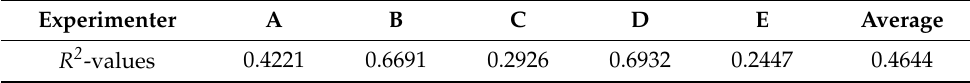
Table 5. Analysis of univariate multiple linear